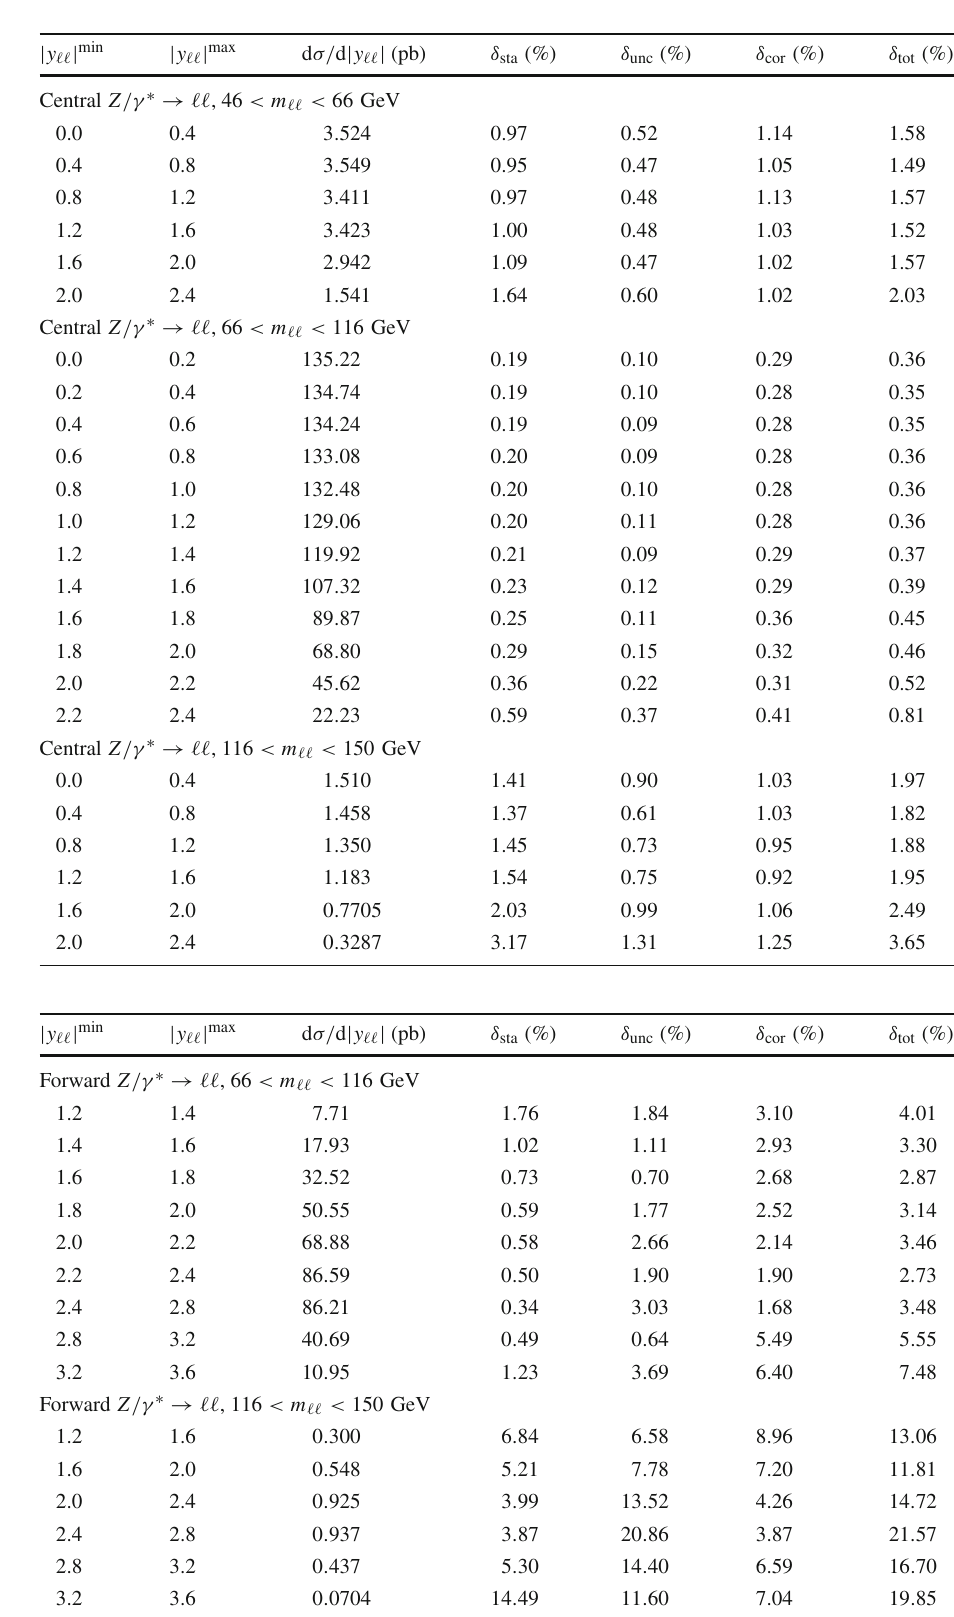
section for the Z /γ ∗ → (cid:3)(cid:3) process in the central region in three dilepton invariant mass regions, extrapolated to the common fiducial region. The relative statistical ( δ sta ), uncorrelated systematic ( δ unc ), correlated systematic ( δ cor ), and total ( δ tot ) uncertainties are given in percent of the cross-section values. The overall 1 . 8% luminosity uncertainty is not included